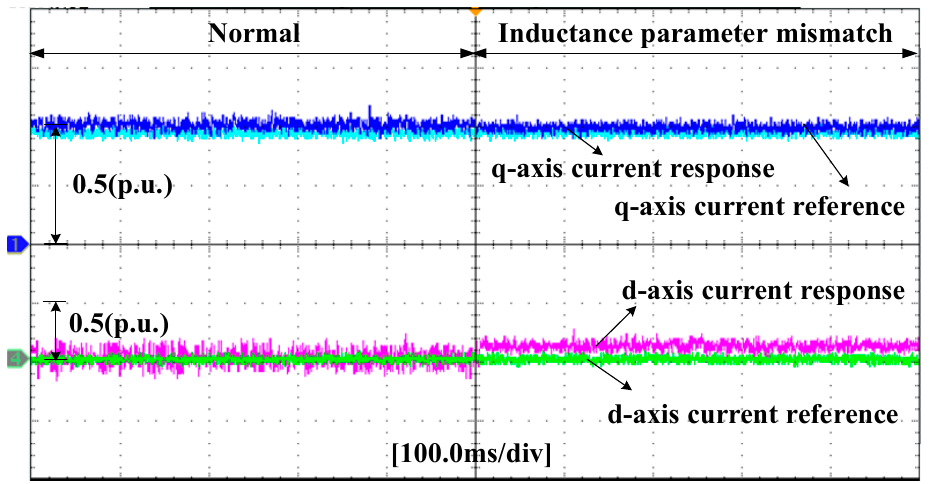
Figure 11. Experimental results of the conventional PCC method under inductance parameter perturbation.